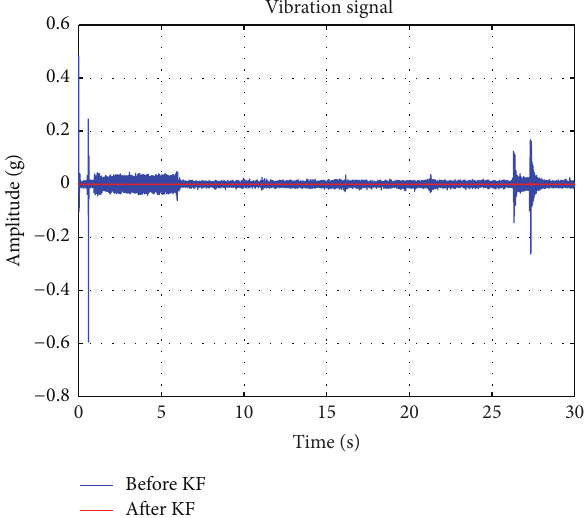
Figure 9: Comparison of the vibration levels before and after the KF from the acceleration